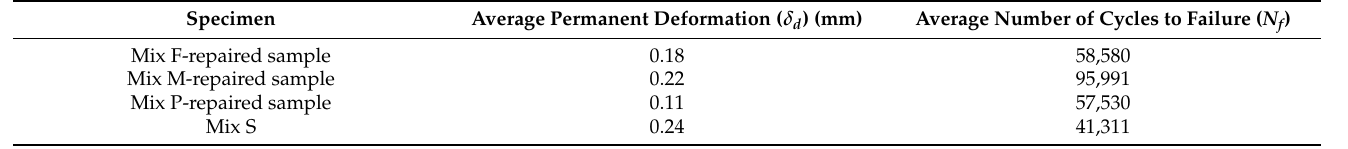
Table 4. Fatigue lives and permanent deformation before failure of different